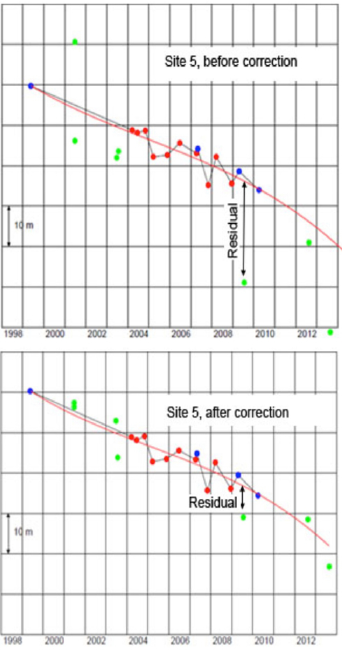
Figure 4. Elevation time series for site 5 near the grounding line of Zachariæ Isstrøm (circled in red in Fig. 5) before the DEM correction is applied (upper panel) and after the DEM correction (lower panel). Altimetry observations are from ICESat (red) and ATM (blue). Green dots mark elevations derived from ASTER